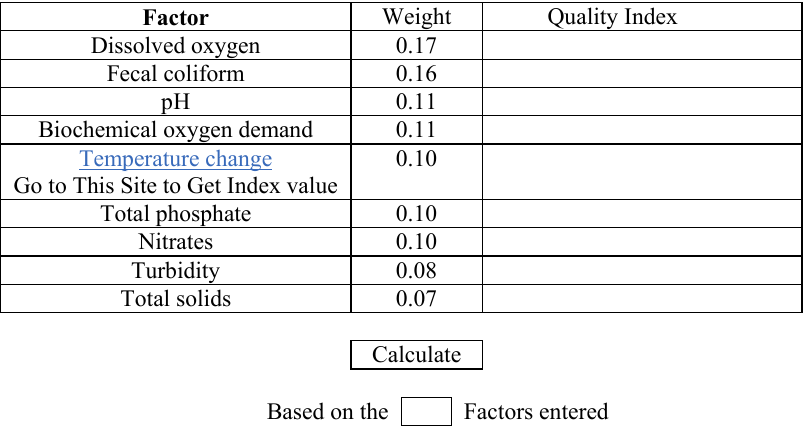
The seasonal average of the WQI parameters measured in the stationaries of the Cesar River Factor Measurement